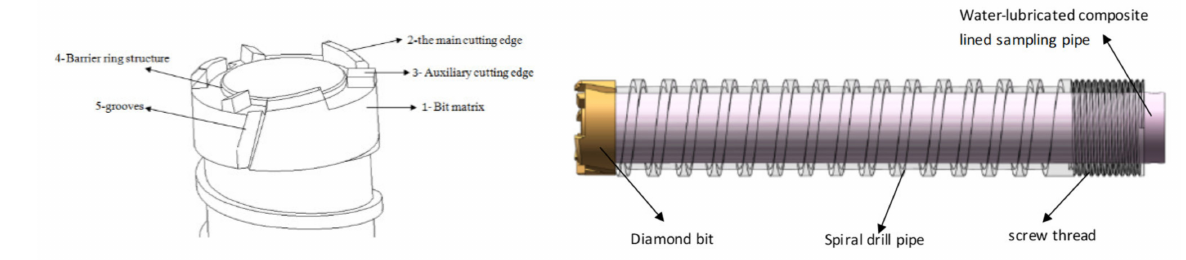
Figure 7. The novel low-load drill bit developed for the Jiaolong manned submersible.